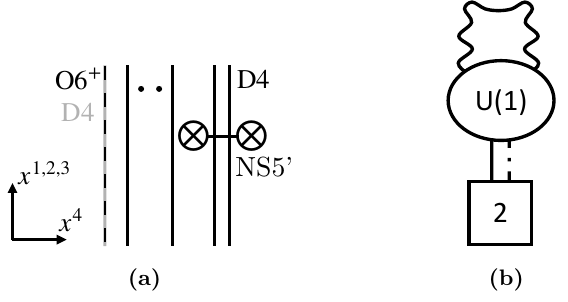
Figure 17. (a): the brane configuration for the monopole screening contribution to the v = e n − 1 + e n sector in T V · T V . (b): the corresponding quiver